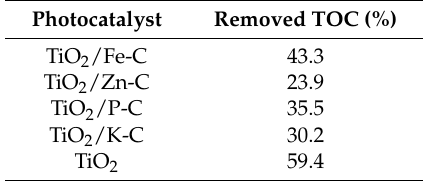
Table 4. TOC removal after 6 h of solar irradiation with the photocatalysts